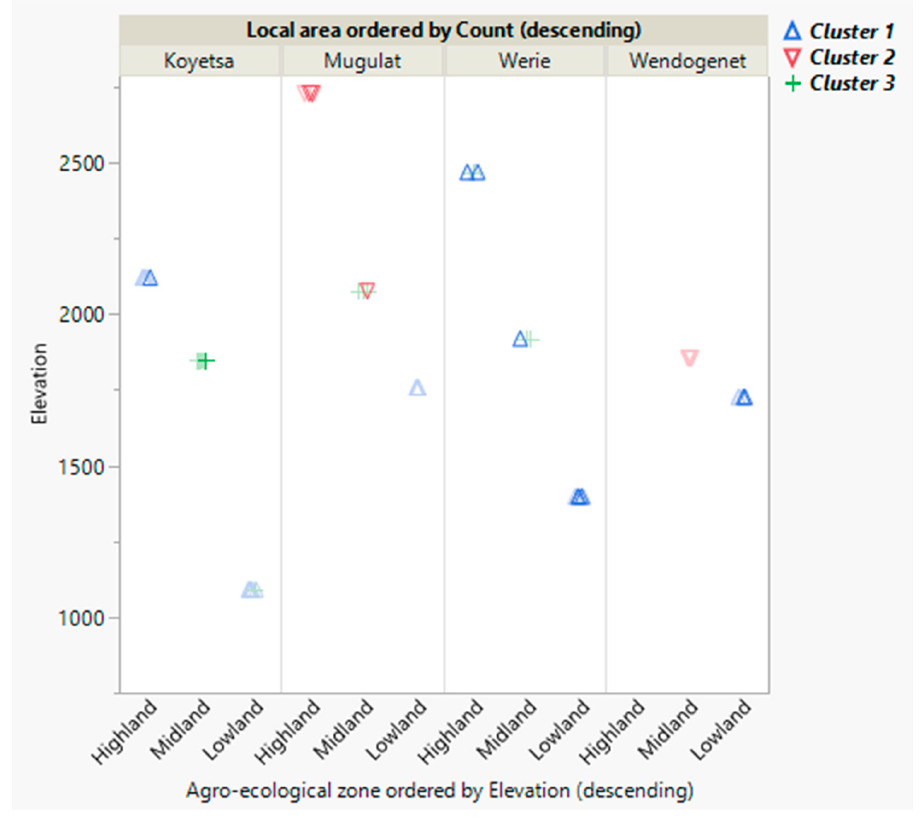
Figure 3. Scatter plot of most likely clusters of Ethiopian honey bee samples of this study based on latent class analysis using classical morphometric ecotypes (highland, midland, lowland), mitochondrial haplotypes of this study (Y1, Y2, Y3, A1, O5’) as previously reported [16] and three clusters based on diversity parameters (number of segregating sites, average number of nucleotide differences, average number of pairwise differences, Watterson estimator) using a nuclear marker on chromosome seven, denoted as r7.4.